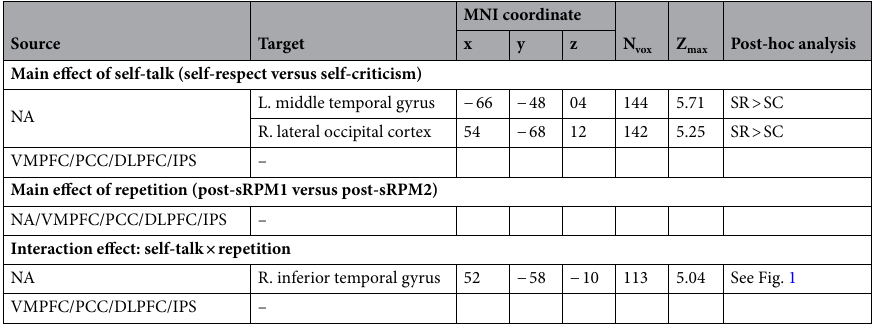
Table 3. Results of the seed-based functional connectivity analysis for resting-states after performing the short form of Raven’s Progressive Matrices (sRPM) in the two different self-talk groups: self-respect and